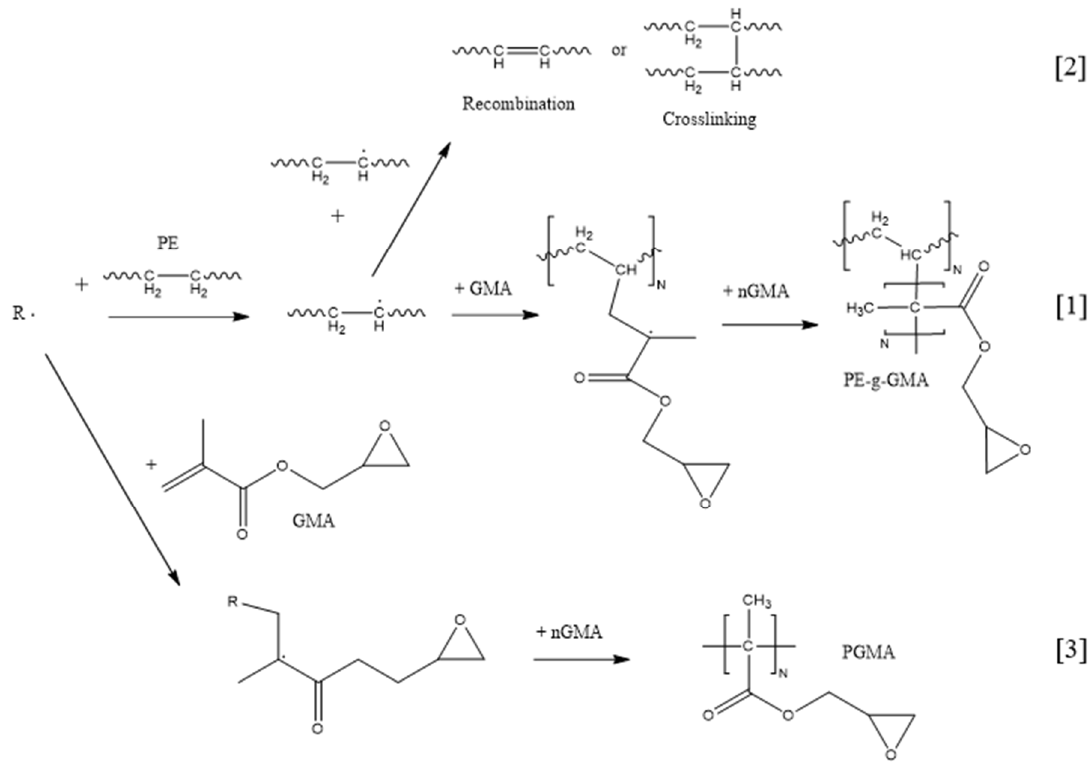
Figure 2. Reaction mechanism based on the literature [3,5–7,9–11,14,33,34].